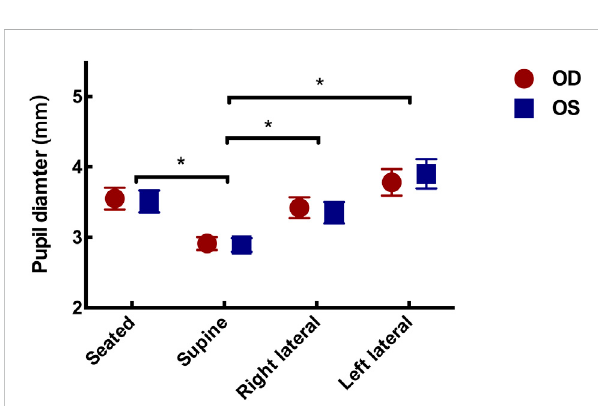
FIGURE 5 Pupil diameter change in different positions. The horizontal pupil diameter became constricting when the position changed from seated to supine ( p = 0.09 for right eye, and 0.08 for left